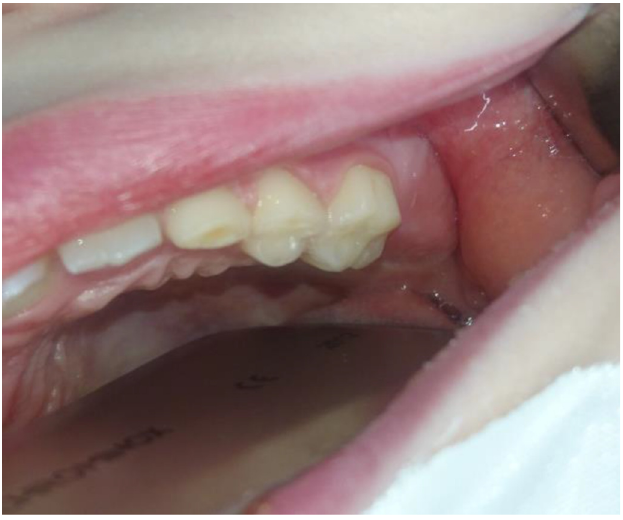
Fig. 1. Clinical view: Slight swelling of the vestibule at tooth 26.